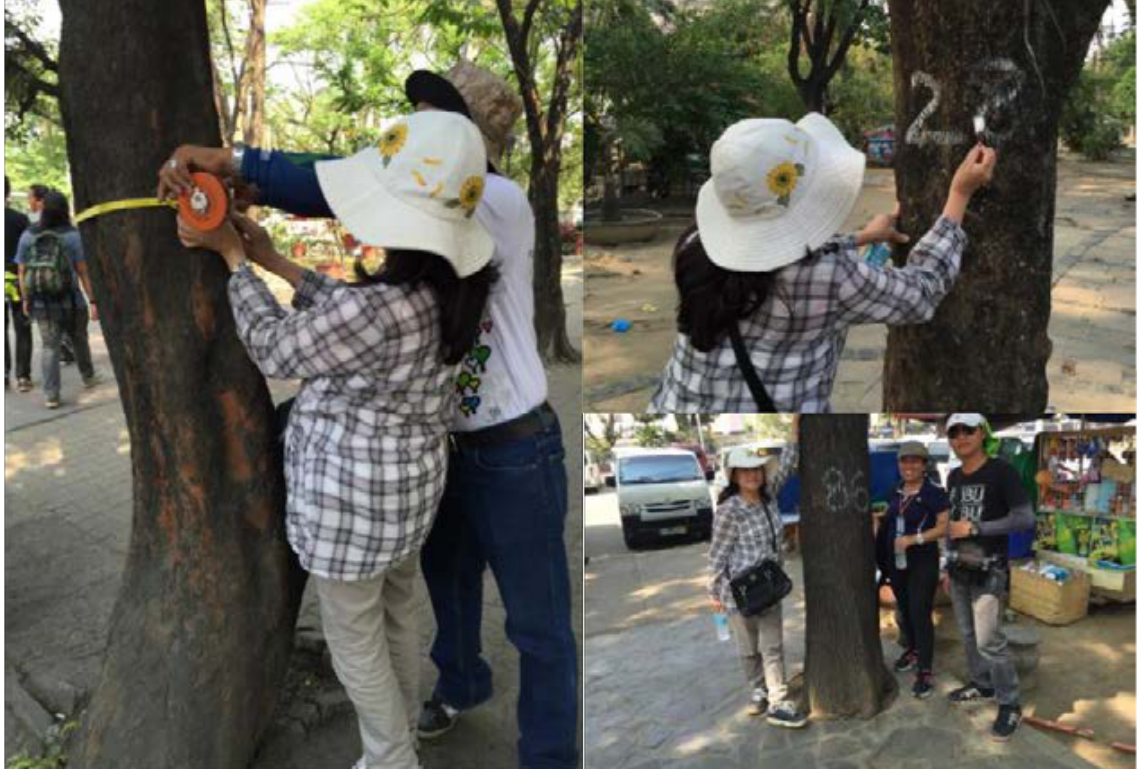
Figure 1. Urban Green Space Inventory as a Supply Determinant of Urban Biodiversity